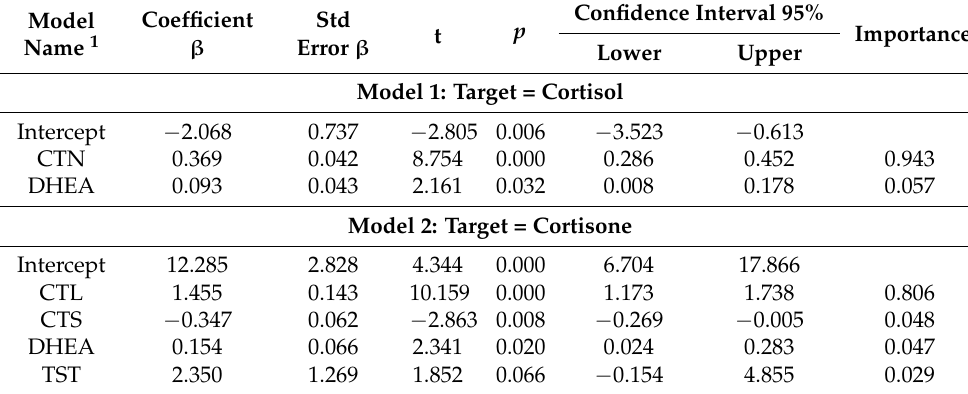
Table 6. Calculated coefficients description for the designed